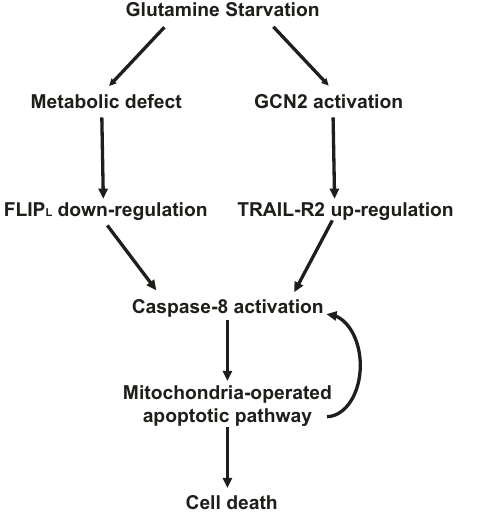
Fig. 8 Schematic diagram of the apoptosis mechanism activated by glutamine limitation in glutamine-addicted tumor cells. Glutamine deprivation or inhibition of glutamine metabolism will result in GCN2-mediated TRAIL-R2 upregulation and metabolic stress-induced FLIP L downregulation, leading to caspase-8 activa- tion and